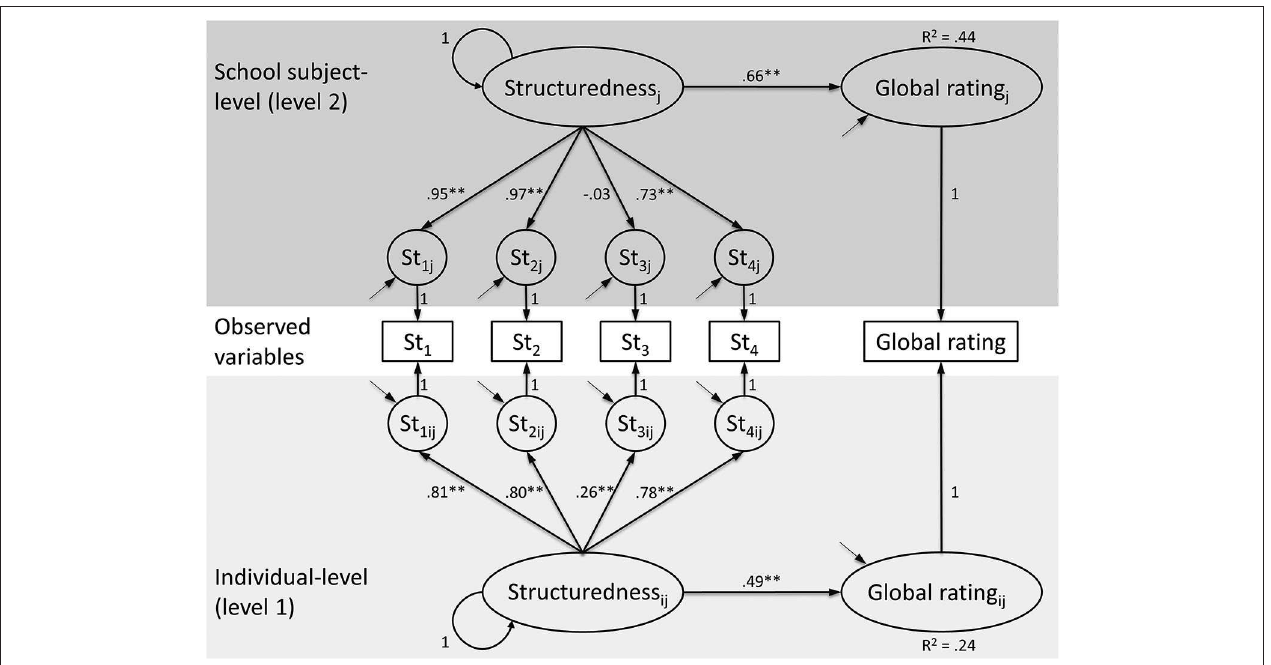
FIGURE 4 | (Doubly) Latent structure equation model for the correlation between structuredness and global rating at individual and school subject level. Latent constructs are represented as circles and indicators of these variables as squares. The boxes representing the observed variables are associated with both individual and subject-specific constructs (see Marsh et al., 2012); residual variances are not reported. The subscripts ij indicate that these variables take on different values for each student i in each classroom j . Number of observations: 15,639, number of clusters: 11; χ 2 (10) SRMR (between) 0.09; * p < 0.05, ** p < =